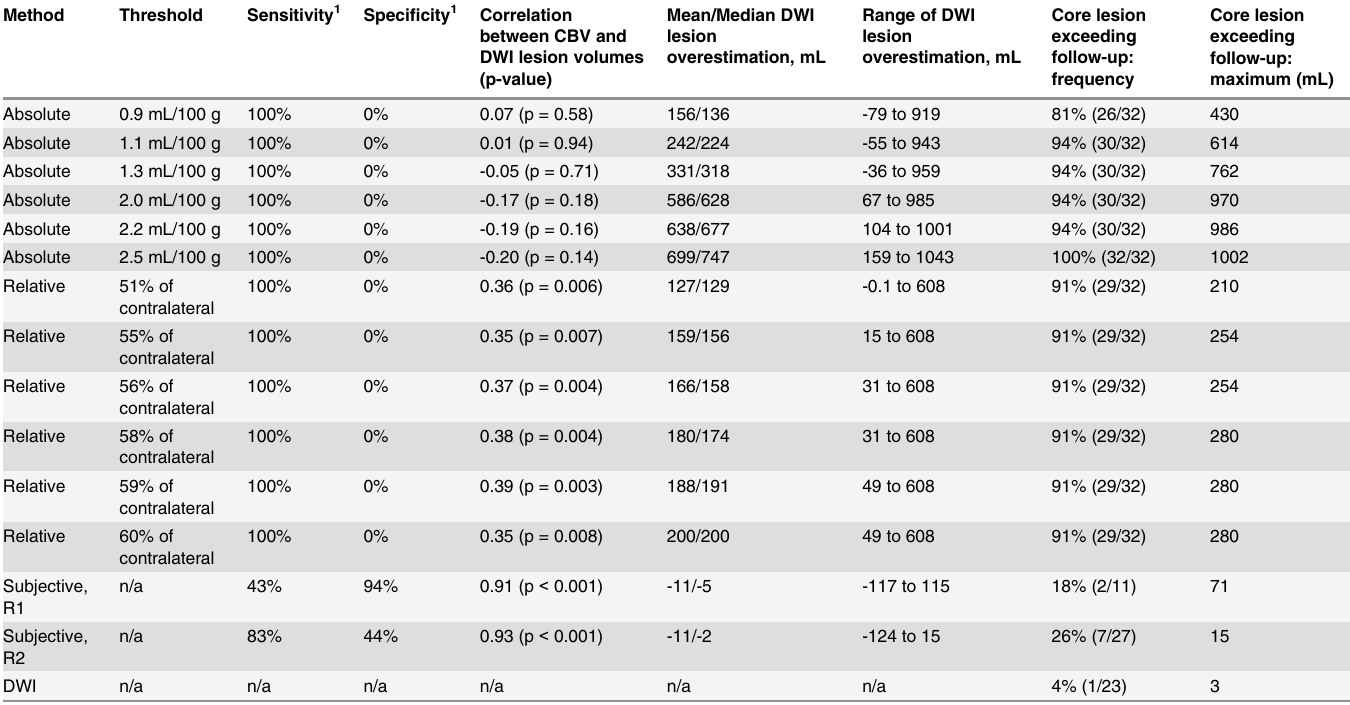
Table 2. Comparison of core lesion measurement